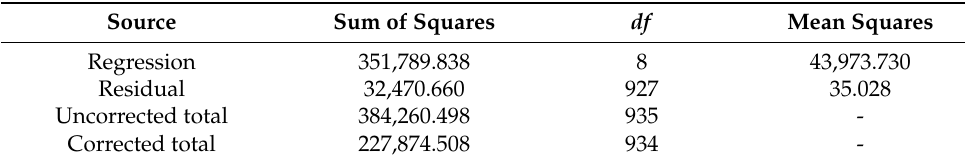
Table 4. ANOVA table with RH less than 70%.